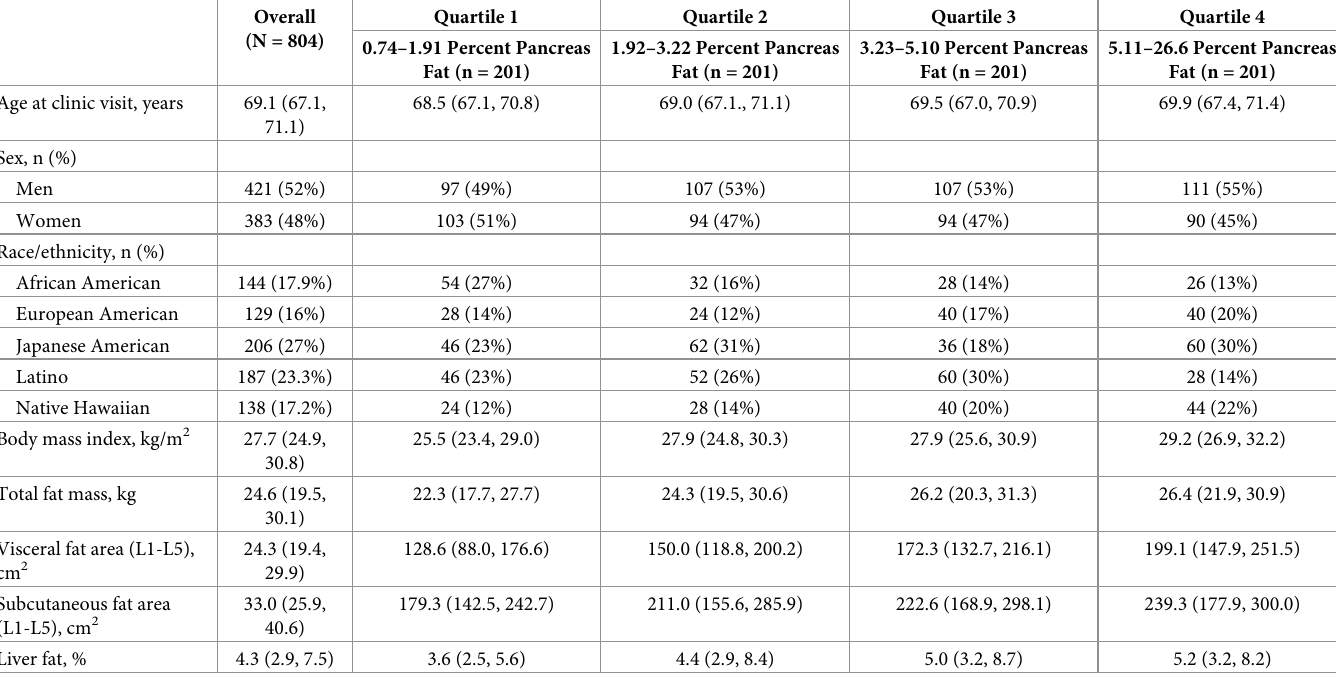
Table 1. Descriptive characteristics of MEC-APS subject by quartiles of percent pancreatic fat (N = 804) a